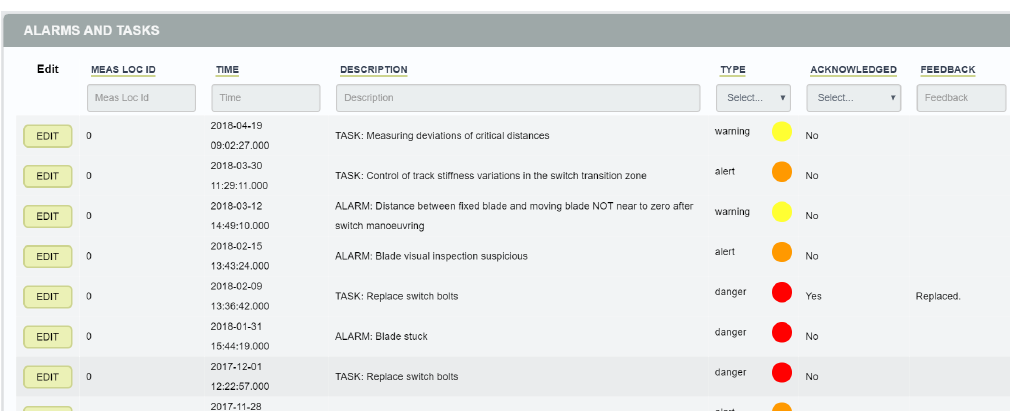
Figure 13. Table of alarms and